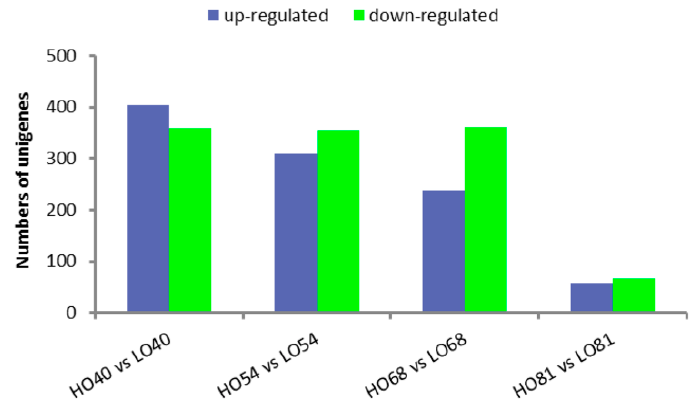
Figure 2. Differentially expressed genes (DEGs) between HO and LO at four development stages. Genes up-regulated (blue) and down-regulated (green) in HO relative to LO at matched developmental stages.